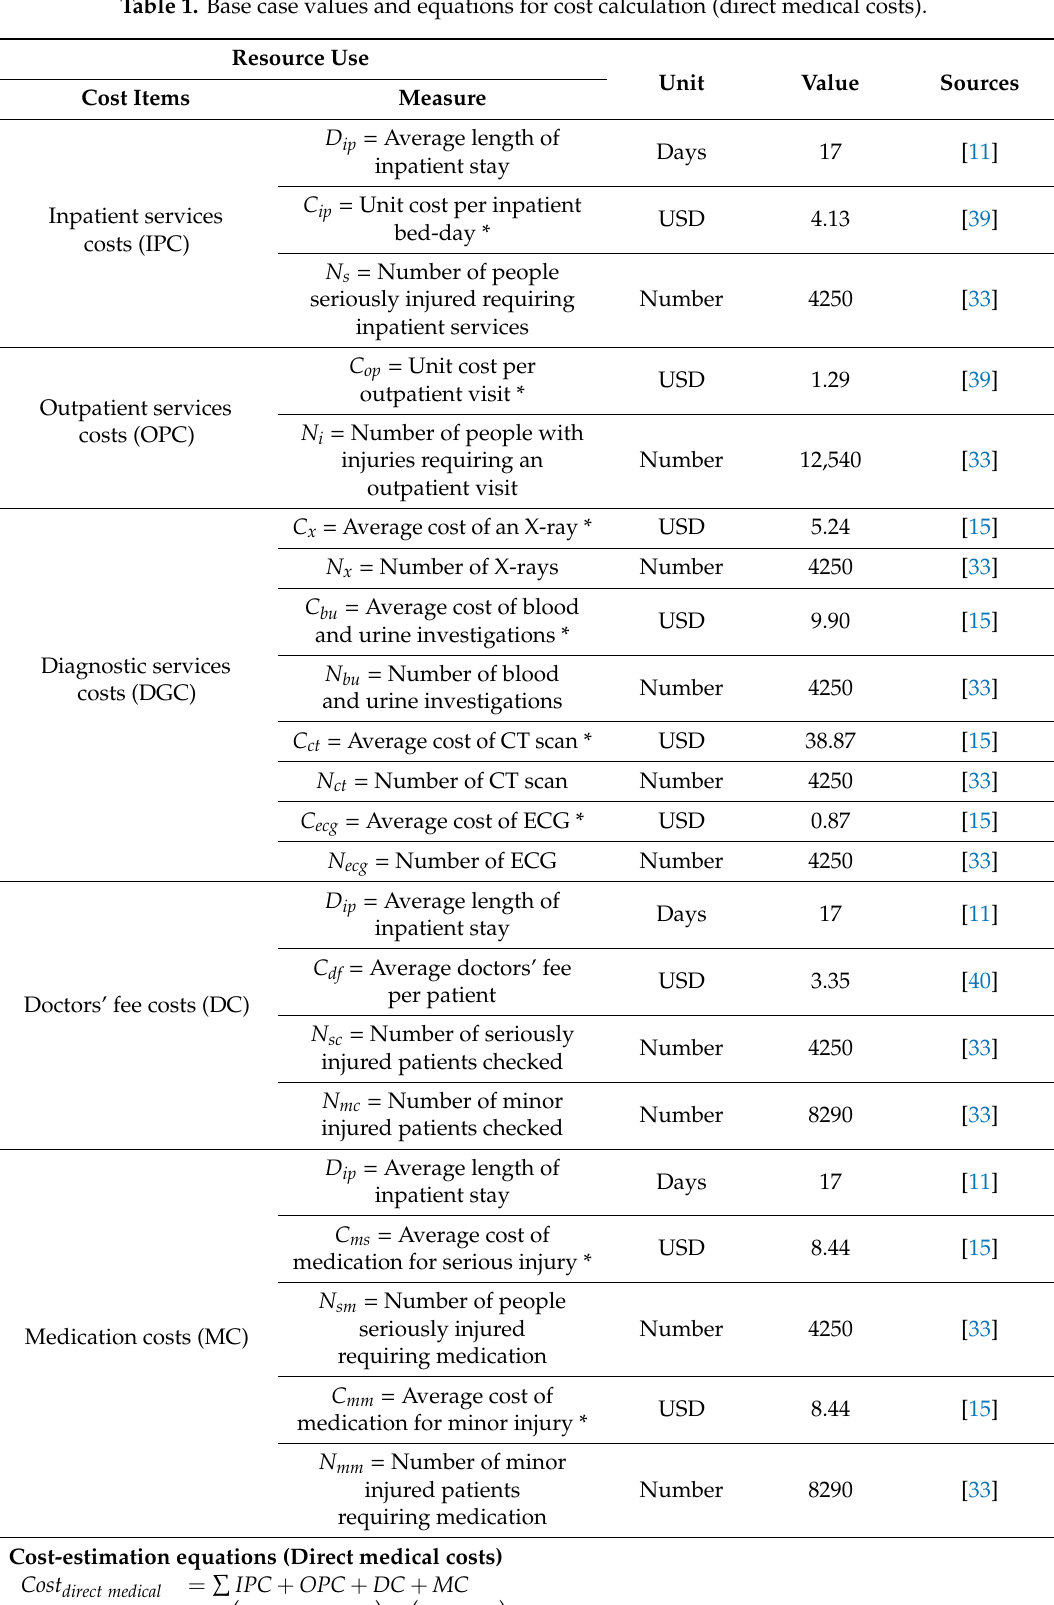
Table 1. Base case values and equations for cost calculation (direct medical costs). Resource Use Unit Value Sources Cost Items